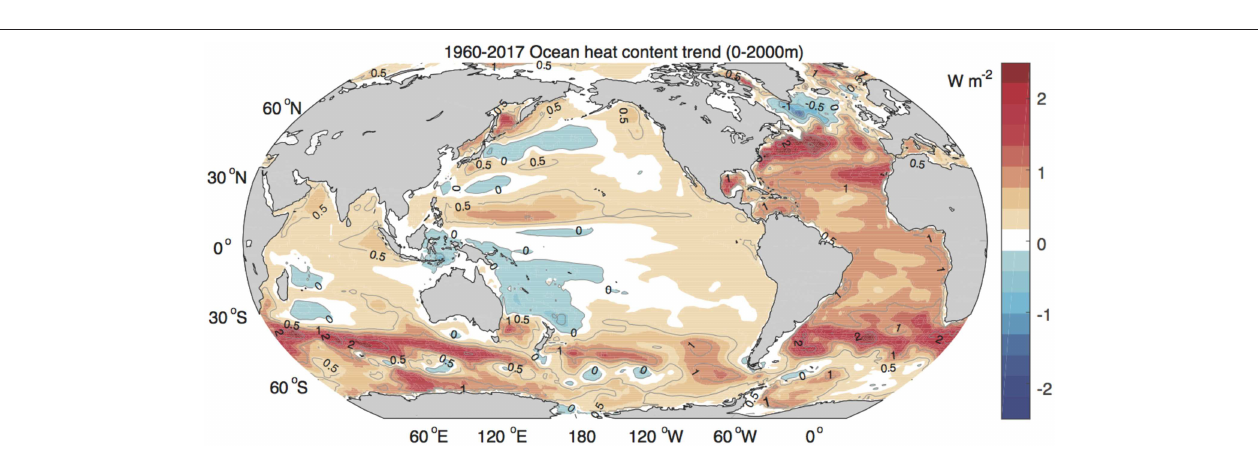
FIGURE 9 | Observed ocean warming rate in the upper 2000m since 1960 (Figure updated from Cheng and Zhu, 2016 and Cheng et al., 2017). The data used to generate this figure is from gridded ocean temperature analysis in Cheng et al. (2017), and this analysis is based on all available in situ ocean subsurface temperature observations (including XBT data) from World Ocean Database (Boyer et al.,